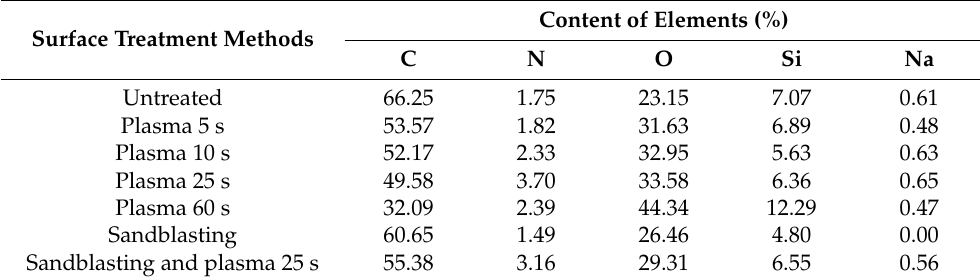
Table 10. Element composition and corresponding content of CF/EP sample surface after different surface